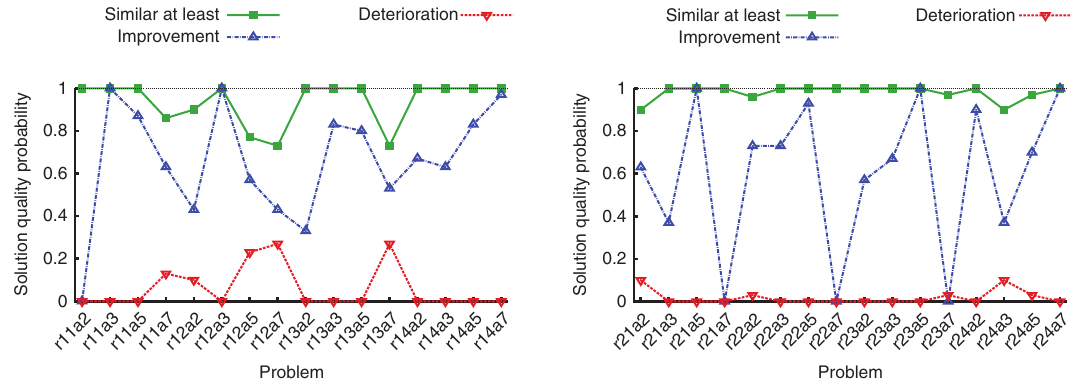
Figure 2: Probability that Enhanced ILS Improves Solution Quality of ILS.